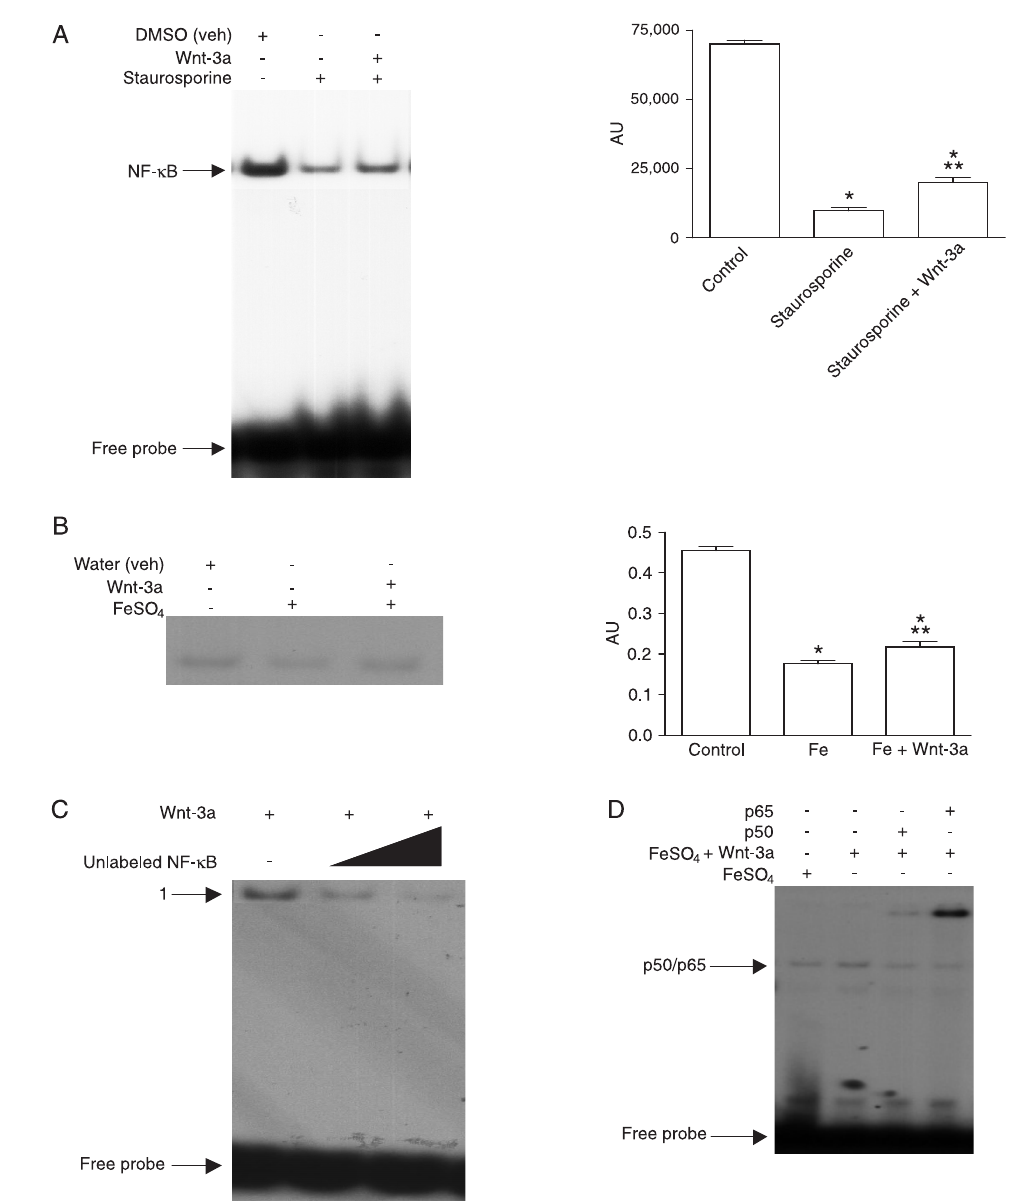
Figure 7. Effect of Wnt-3a on NF-κB suppression induced by staurosporine and FeSO 4 on PC12 cells. Nuclear proteins (2.5 µg) were extracted from PC12 cells pre-incubated (24 h) with mouse recombinant peptide Wnt- 3a (100 ng/mL) followed by 24-h incubation with A , 500 nM staurosporine or B , 10 mM FeSO 4 . Densitometric analyses (arbitrary units, AU) of the NF-κB band are presented in Panels A and B . Data are reported as means ± SEM for 3 independent experiments *P < 0.001 vs control; **P < 0.05 vs staurosporine and FeSO 4 (one-way ANOVA followed by the Newman-Keuls test). C , Competition studies were performed using nuclear extracts (2.5 µg) from PC12 cells pre-incubated (24 h) with mouse recombinant protein Wnt-3a (100 ng/mL) followed by 24-h incubation with saline in the absence and in the presence of unlabeled specific oligonucleotide (2.5- and 10-fold molar excess), as indicated. D , Supershift assays were performed with nuclear proteins (2.5 µg) extracted from PC12 cells pre-incubated (24 h) with mouse recombinant peptide Wnt-3a (100 ng/mL) followed by 24-h incuba- tion with FeSO 4 (10 mM) in the absence or presence of antibodies against subunits p50 (1:10 dilution), p65 (1:10 dilution), as indicated. Antibodies were added 20 min prior to the addition of the radiolabeled NF-κB consensus oligonucleotide. The position of the specific NF-κB/DNA binding complex p50/p65 (band) is indicated. The local- ization of the probe is also indicated. Results are representative of 3 independent